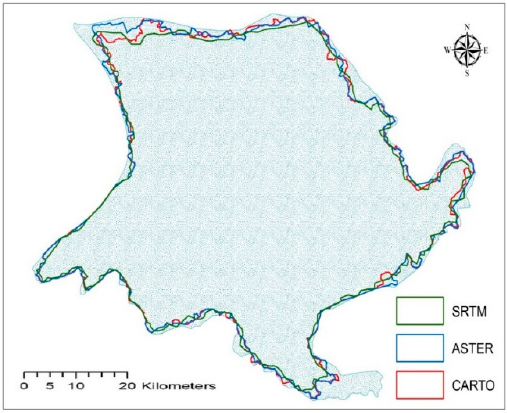
Figure 6. Comparison of delineated watersheds obtained using three different DEMs.